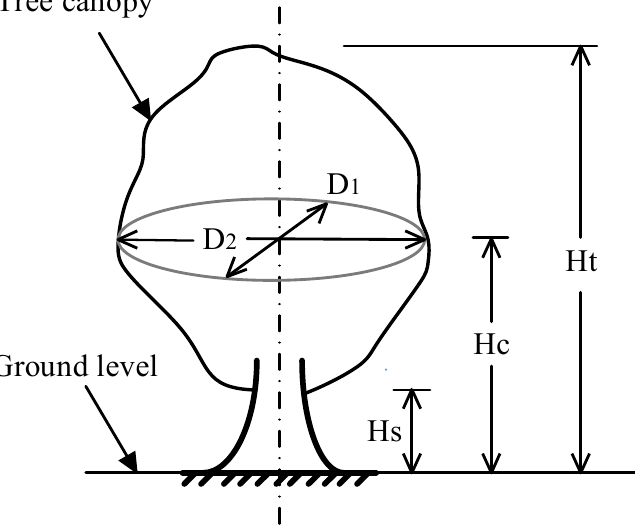
Figure 8. Schematic diagram of Citrus reticulate Blanco cv. Shatangju tree measurement parameters.